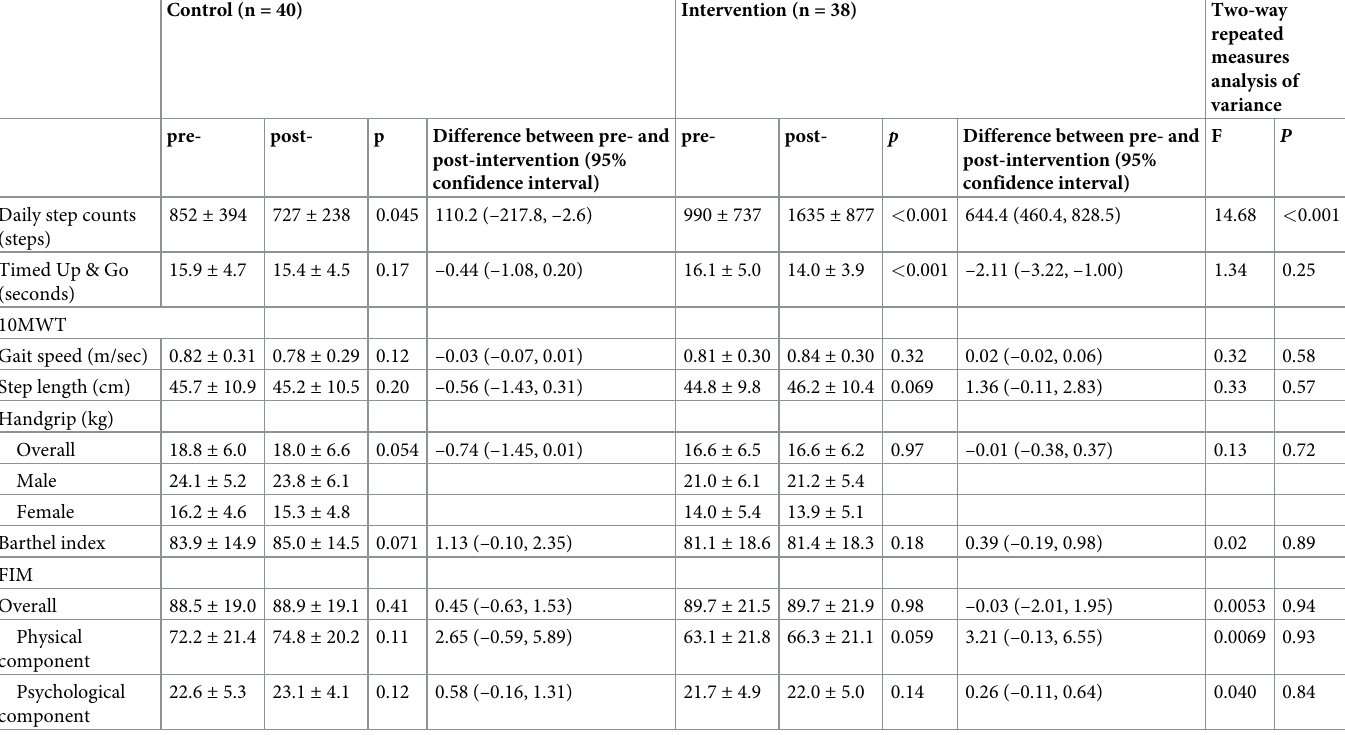
Table 2. Results of physical activity, performance, psychological performance and quality of life. Control (n =